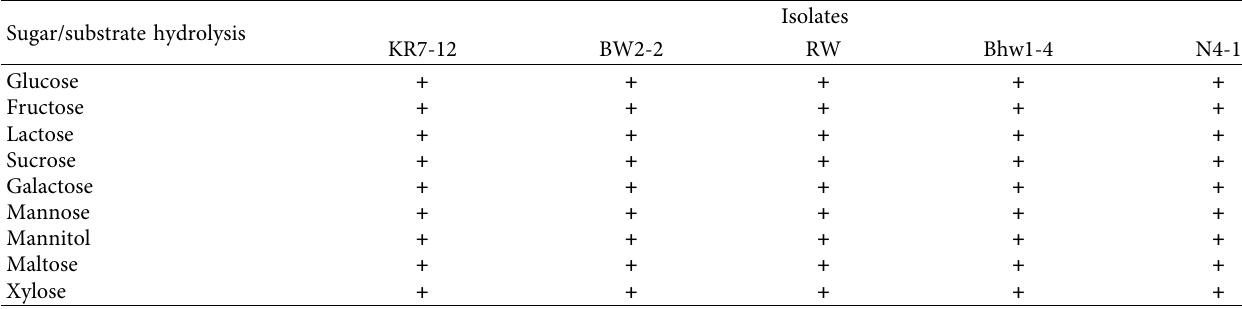
Table 3: Sugar assimilation pattern of